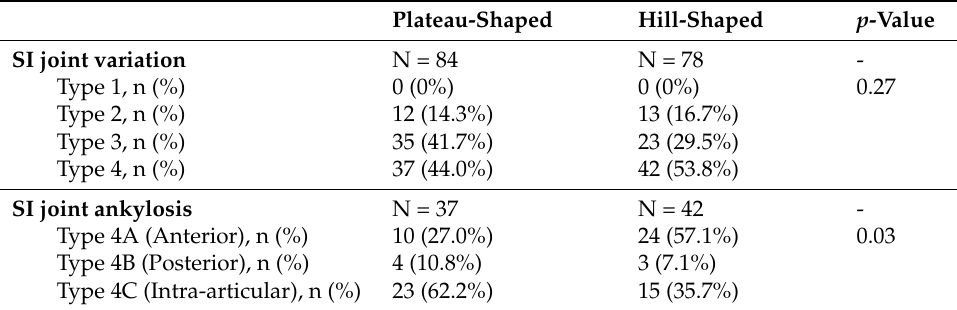
Table 2. Occurrences of OPLL shapes and SI joint